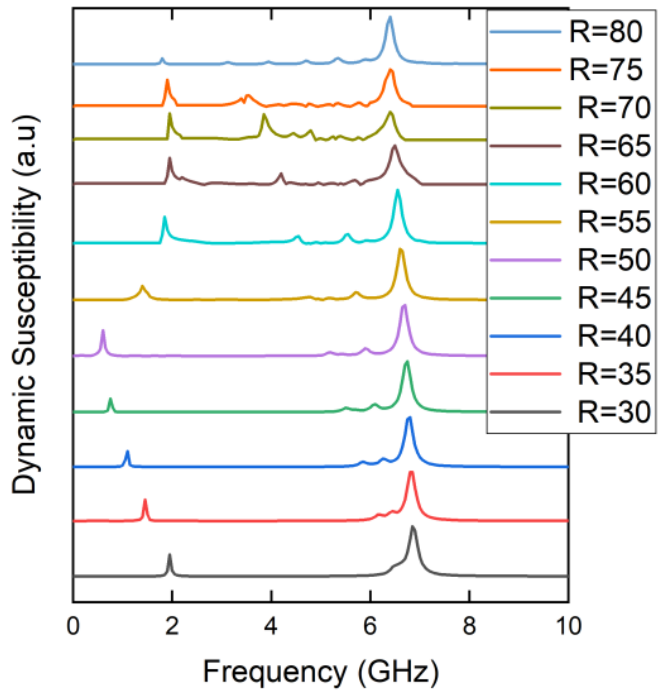
Figure A4. Components of the magnetization (Mx/Ms and Mz/Ms) for each of the geometries that were excited to investigate the FMR spectrum of the 1000 nm long Fe 3 O 4 nanotubes.